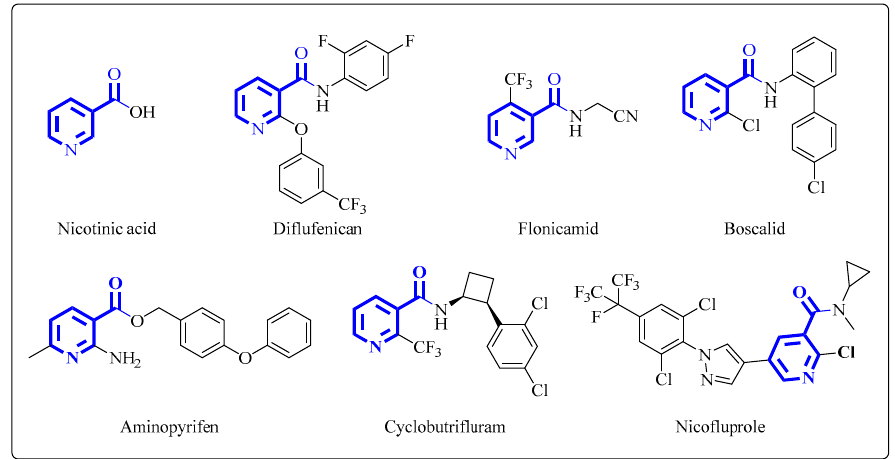
Figure 1. The structures of nicotinic acid and its derivatives.